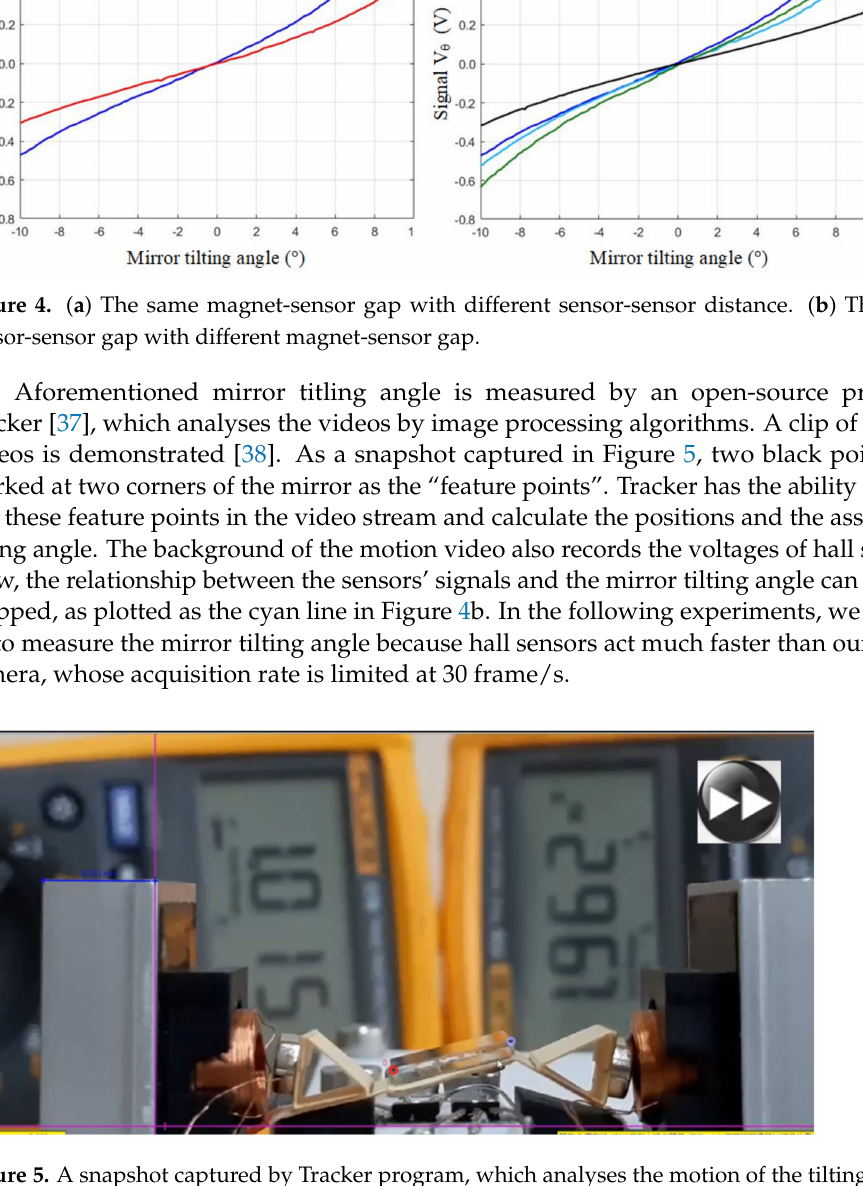
Figure 5. A snapshot captured by Tracker program, which analyses the motion of the tilting